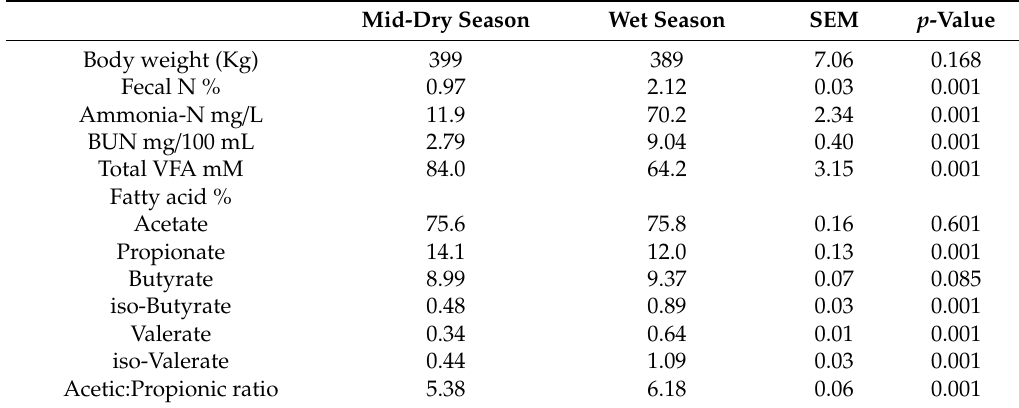
Table 2. Rumen fermentation parameters, body weight, fecal N, and BUN in heifers grazing at mid-dry and wet season (pregnant and lactating,